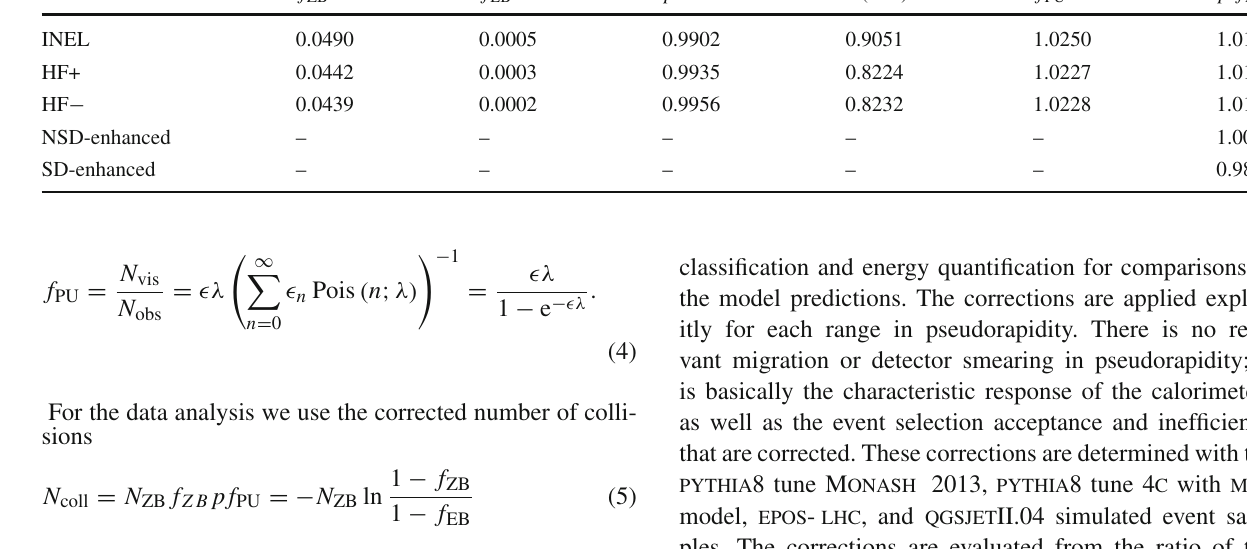
Table 2 Selection factors and purities for various event selection cate- from simulations, and the value quoted here is the average value from gories. Only the first two parameters f EB and f ZB present actual mea- all event generators, with a maximal model dependence of 2%. The surements, from which the other quantities are derived as explained rightmost column quantifies the combined correction due to noise and in the text. The probability (cid:9) to select a single collision is determined pileup. All statistical uncertainties are negligible f